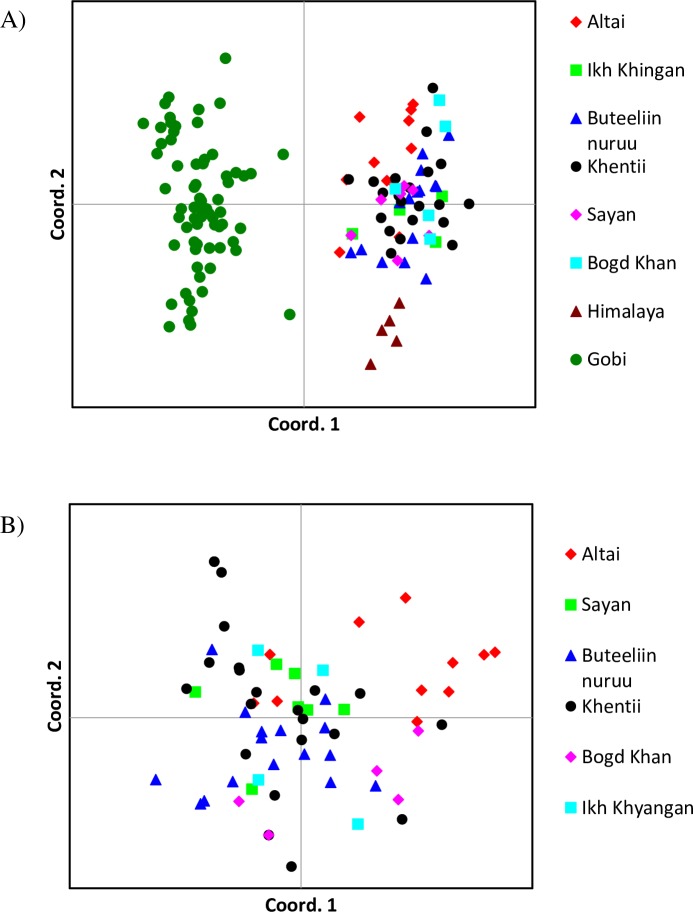
Principal coordinate analysis (PCoA) on individual microsatellite genotypes.A) PCoA based on 13 microsatellite loci from 138 individual brown bears collected at 8 locations across Central Asia. B) PCoA of the bears in 6 geographic locations without Gobi and Himalaya. Each symbol represents a unique individual with symbol color and shape denoting population of origin.